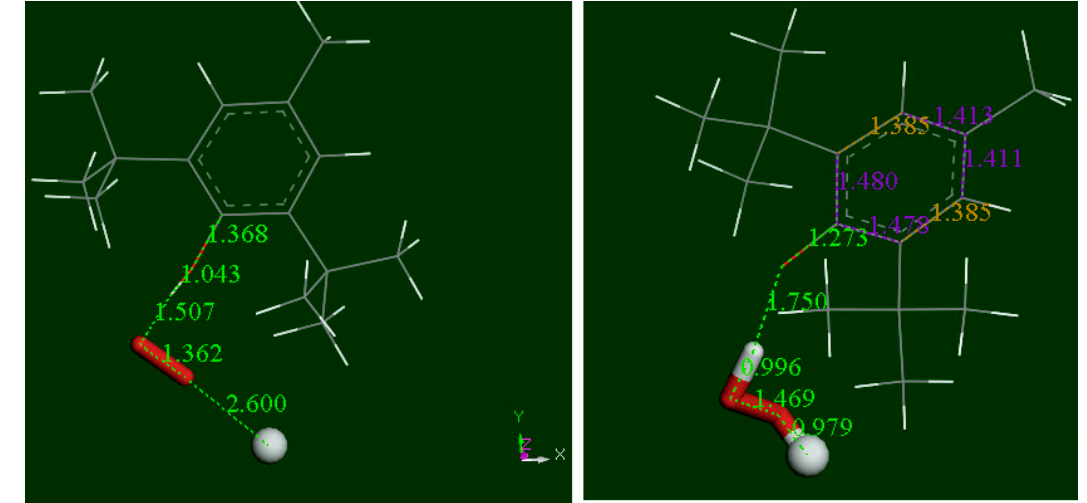
Figure 4. DFT geometry pathway of BHT scavenging the superoxide radical. Left: Minimum obtained after geometry optimization from posing superoxide (stick style, original d(O-O) = 1.373 Å